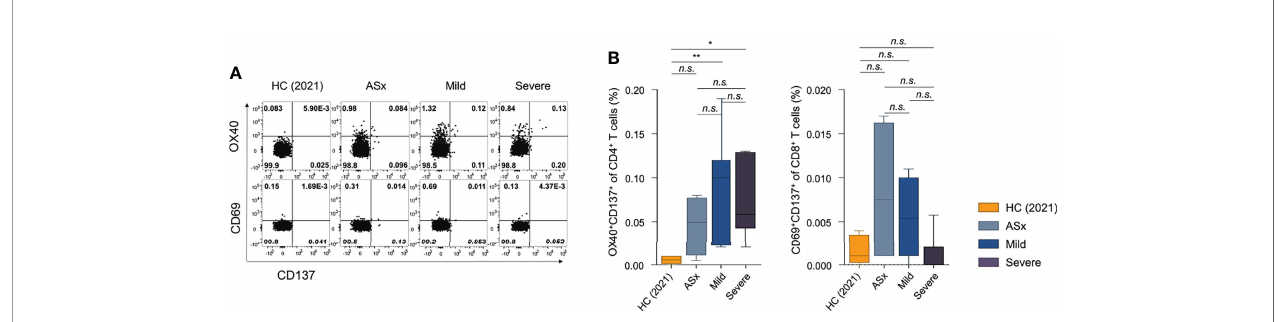
FIGURE 4 | Frequencies of SARS-CoV-2-speci fi c activation-induced markers (AIM) + CD4 + or CD8 + T cells according to the severity of illness. (A) Frequencies of SARS-CoV-2-speci fi c AIM + (OX40 + CD137 + ) CD4 + T cells according to the severity of illness. (B) Frequencies of SARS-CoV-2-speci fi c AIM + (CD69 + CD137 + ) CD8 + T cells according to the severity of illness. Statistical analyses were performed using the Kruskal-Wallis rank-sum test with Dunn ’ s post hoc test in GraphPad Prism ( n.s . : P > 0.05, *P < 0.05, **P <